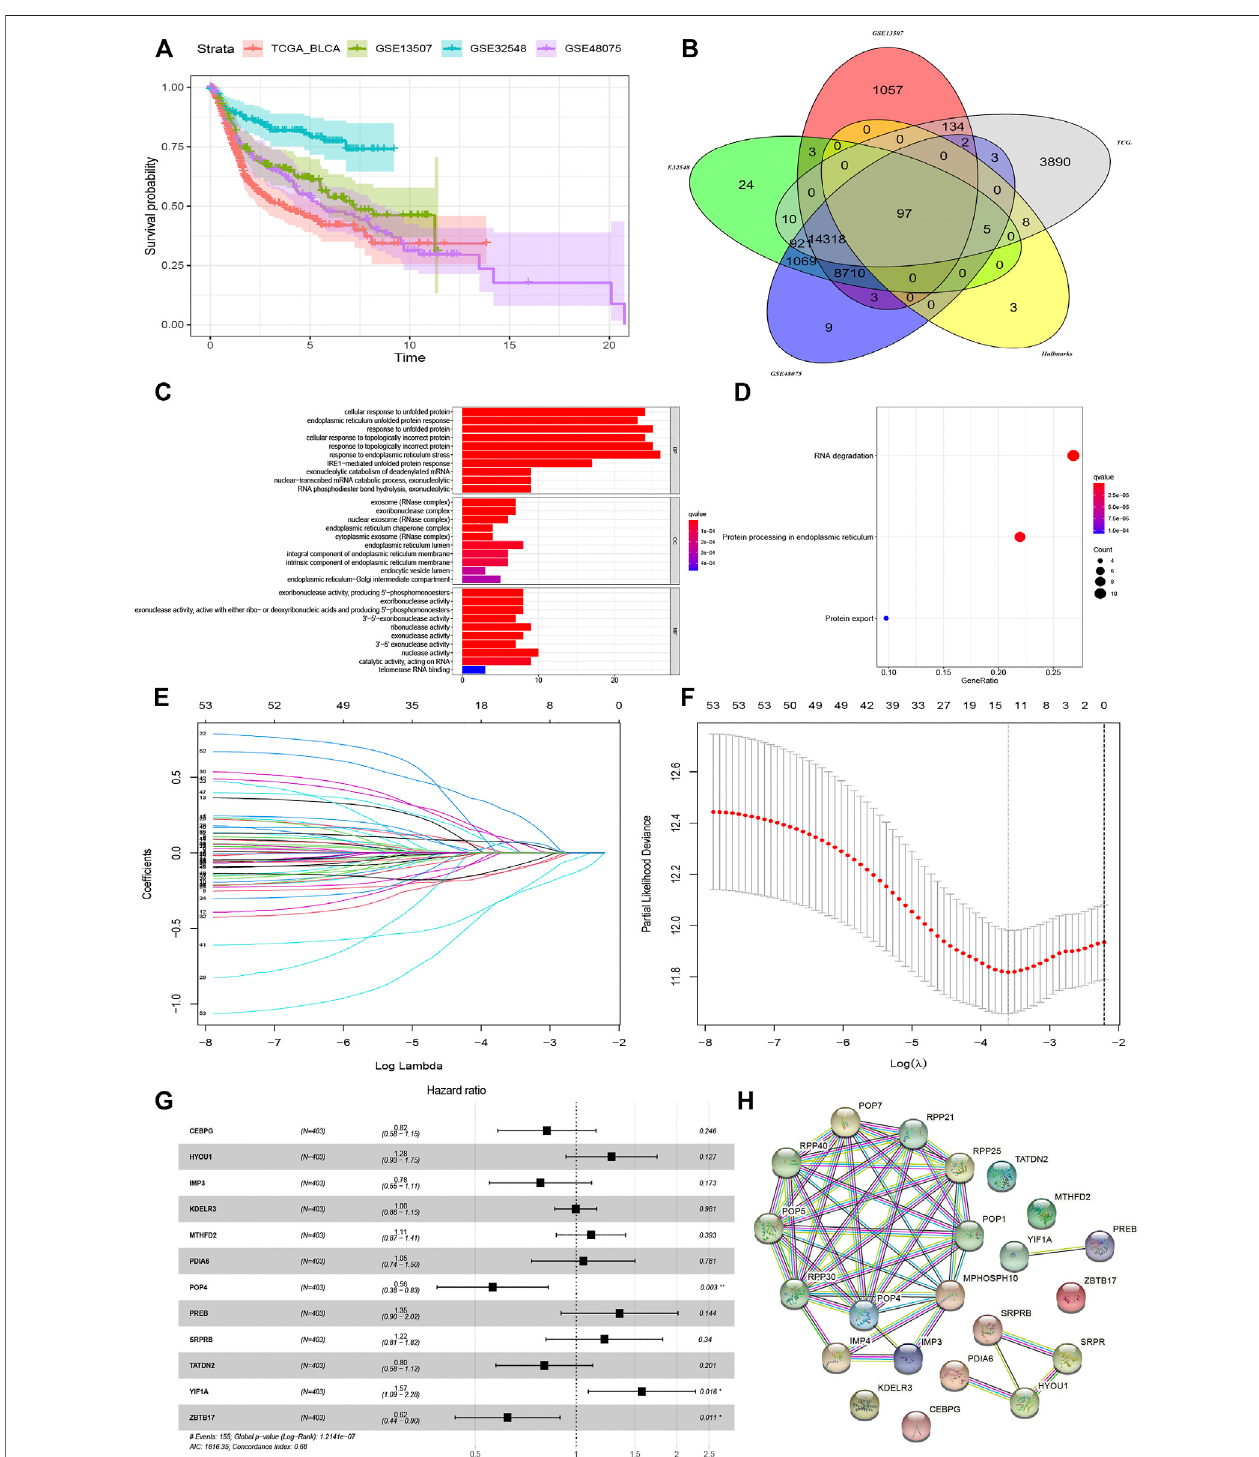
FIGURE 2 | Construction of UPR-related signature utilizing Lasso regression analysis. (A) The outcomes variables of TCGA, GSE13507, GSE32548, and GSE48075. (B) The Venn diagram showed that 97 UPR genes coexisted in the training and three validation sets. (C) GO enrichment analysis revealed that terms of cell response to unfolded protein and endoplasmic reticulum unfolded protein response were signi fi cantly enriched, while KEGG enrichment analysis showed that DNA degradation and protein processing in endoplasmic reticulum closely correlated with the differentially expressed UPR-related genes (D) . (E and F) Differentially expressed UPR-relatedgeneswereincorporatedintoLassoregressionanalysistoscreenoutprognosticUPRgenes. (G) 12prognosisrelatedUPR-relatedgeneswere incorporatedintothemultivariateregressionmodeltogenerateriskscores. (H) Protein-proteininteractionnetworkwasestablishedbySTRINGwithaminimumrequired interaction score (cid:1)